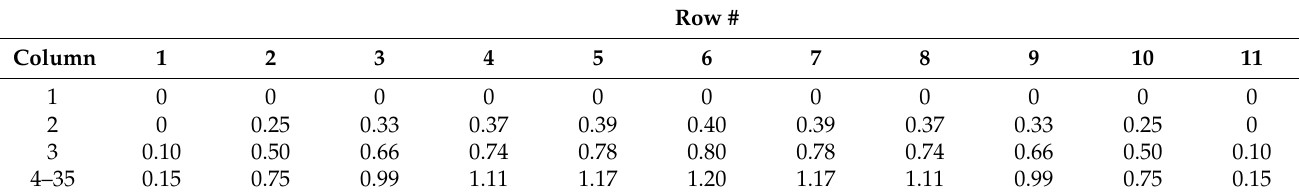
Table 1. Pillar heights for phononic crystal GRINS lens. Values are in mm. Row